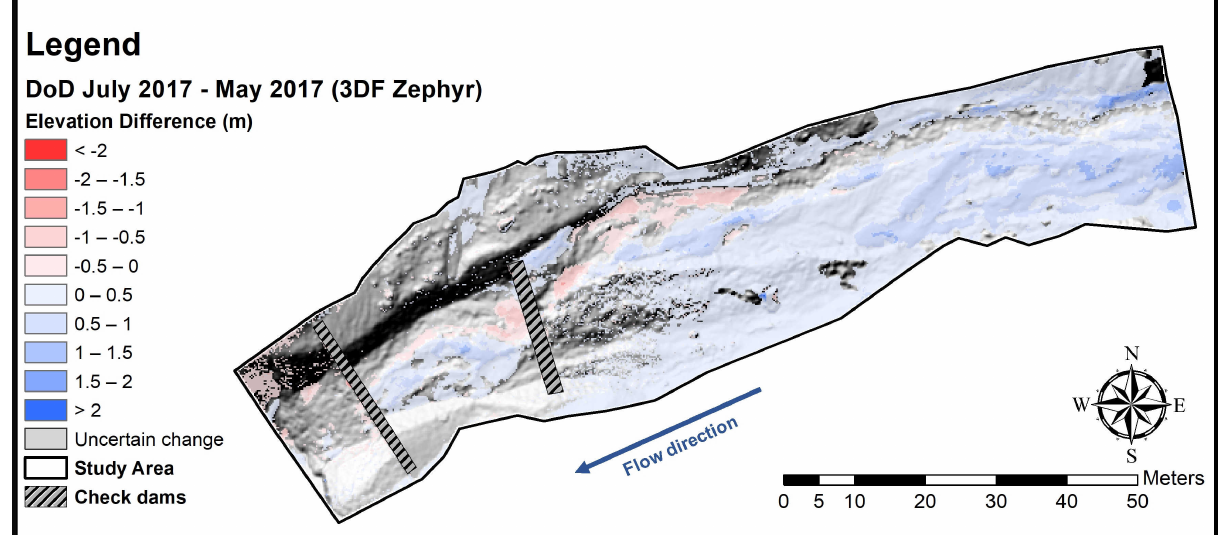
Figure 7. DoD July 2017-May 2017 (dataset processed by 3DF Zephyr).